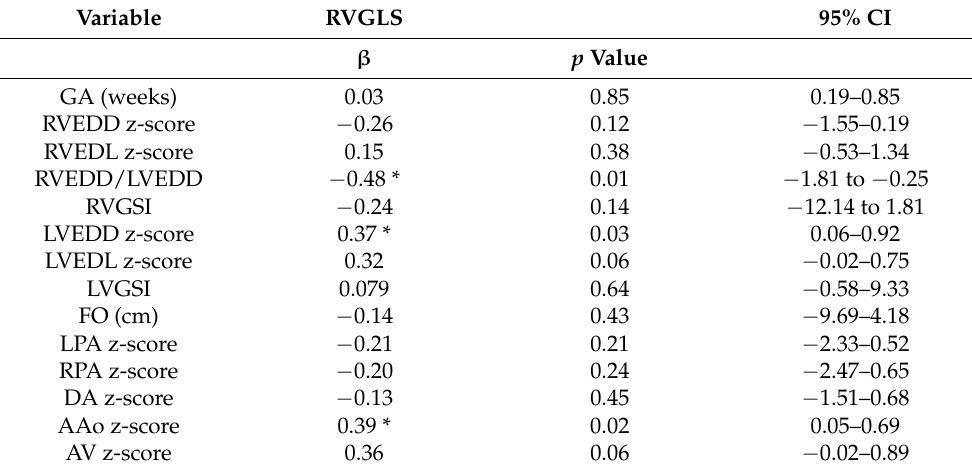
Table 4. Univariate regression analysis for RV myocardial deformation parameters in HLHS fetuses.